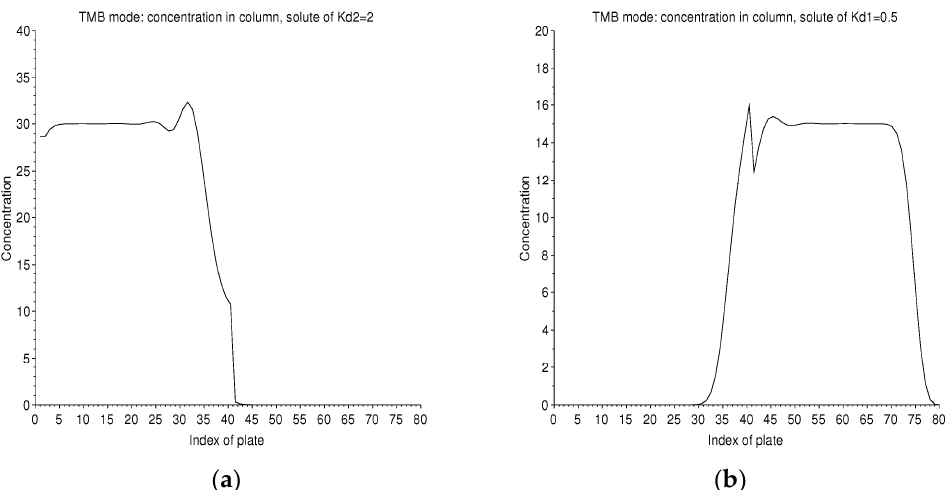
Figure 14. TMB mode: concentration profiles in the two columns of 40 plates, in solvent 2 on the left ( a ) for K d 2 = 2 and in solvent 1 on the right ( b ) for K d 1 = 0.5. This is the start of the twentieth cycle of ebb/flow. Each cycle has a duration of 15 ticks. The separation regime is established. The concentration profile is flat, except at the peak of injection into the 40 cell, which diffuses. We have just injected solvent 2 on the right end of the column, while the solute of K d 2 = 2 is collected. The profile of each solute encroaches a little on the column, which is unfavorable to it.